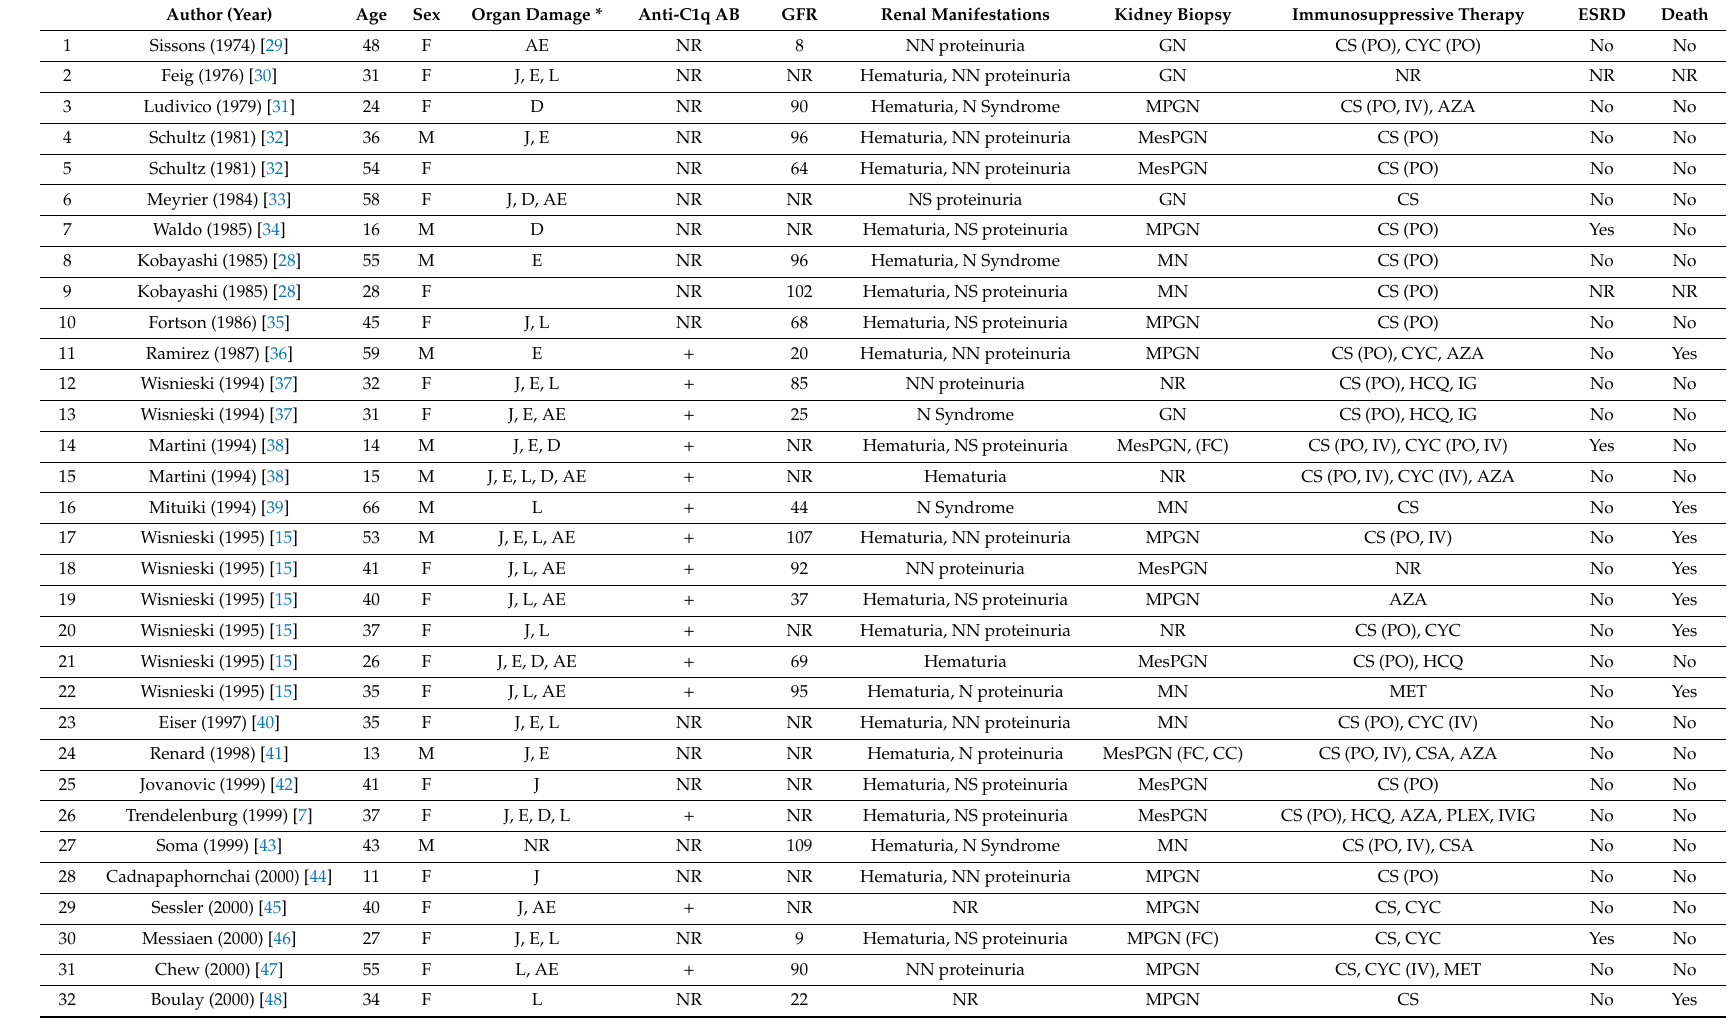
Table 3. Reported cases of HUVS for whom individual data were